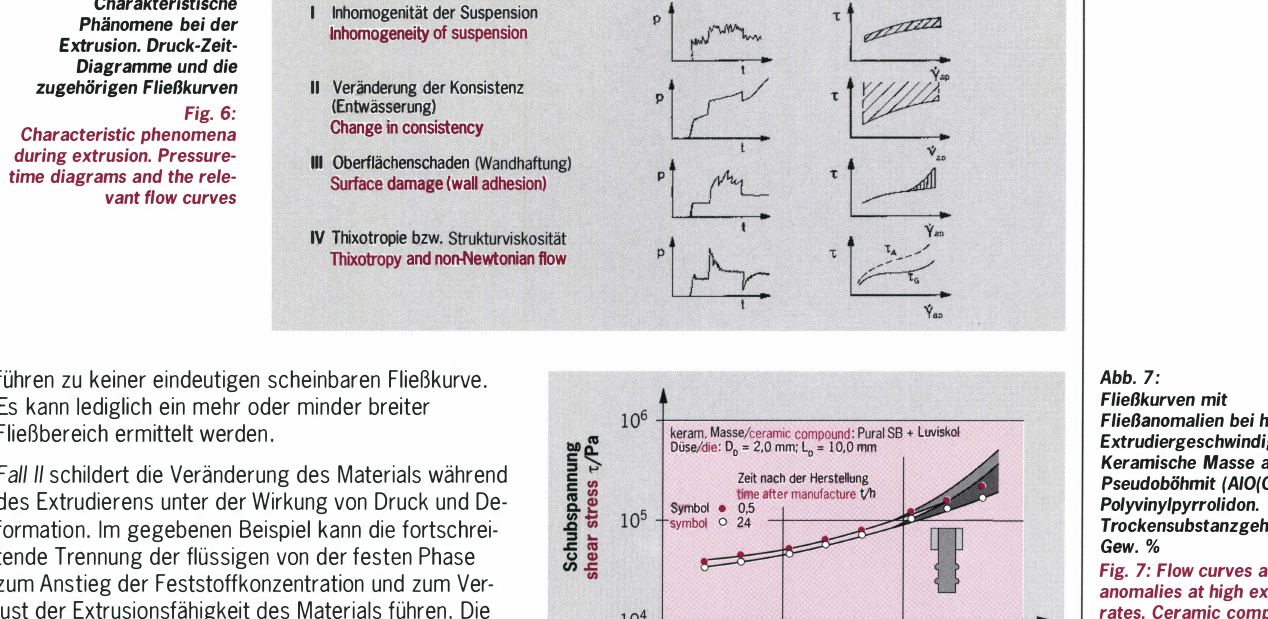
Gew.% Fig. 7: Flow curves and flow anomalies at high extrusion rates. Ceramic compound made of pseudobohmite [AlO(OH}] with polyvinyl pyrrolidone. Dry solids content 60 % by